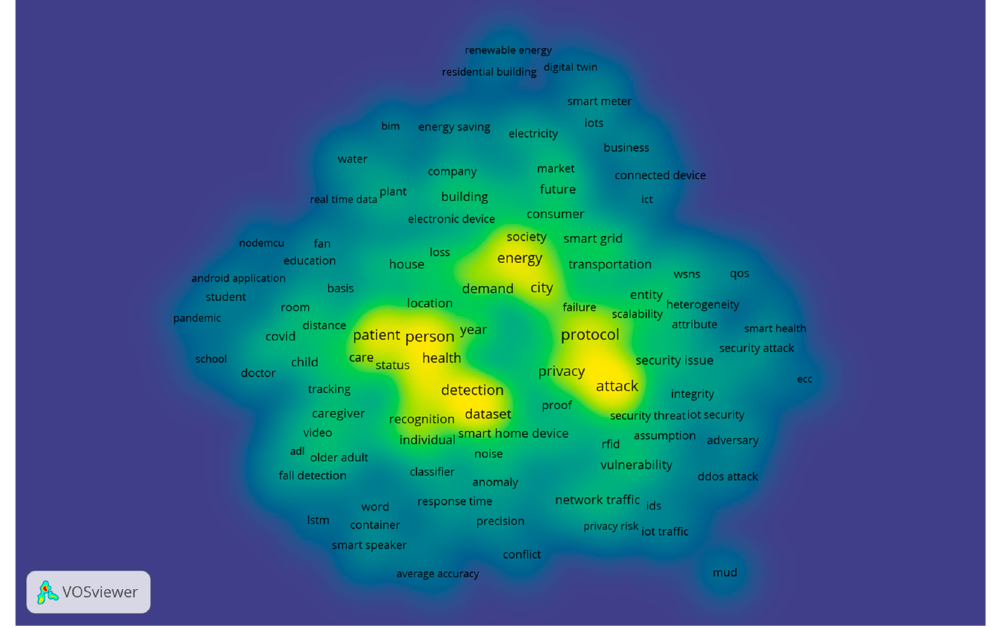
Figure 15. Density visualization 2020.